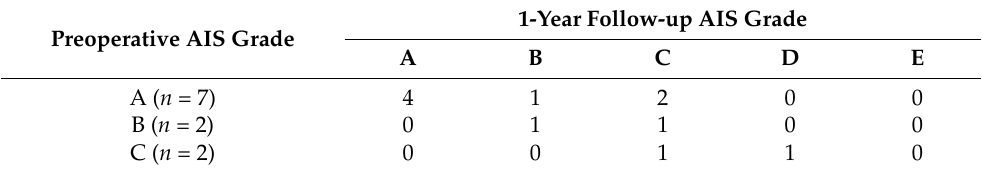
Table 2. Preoperative and 1-year follow-up AIS grade.